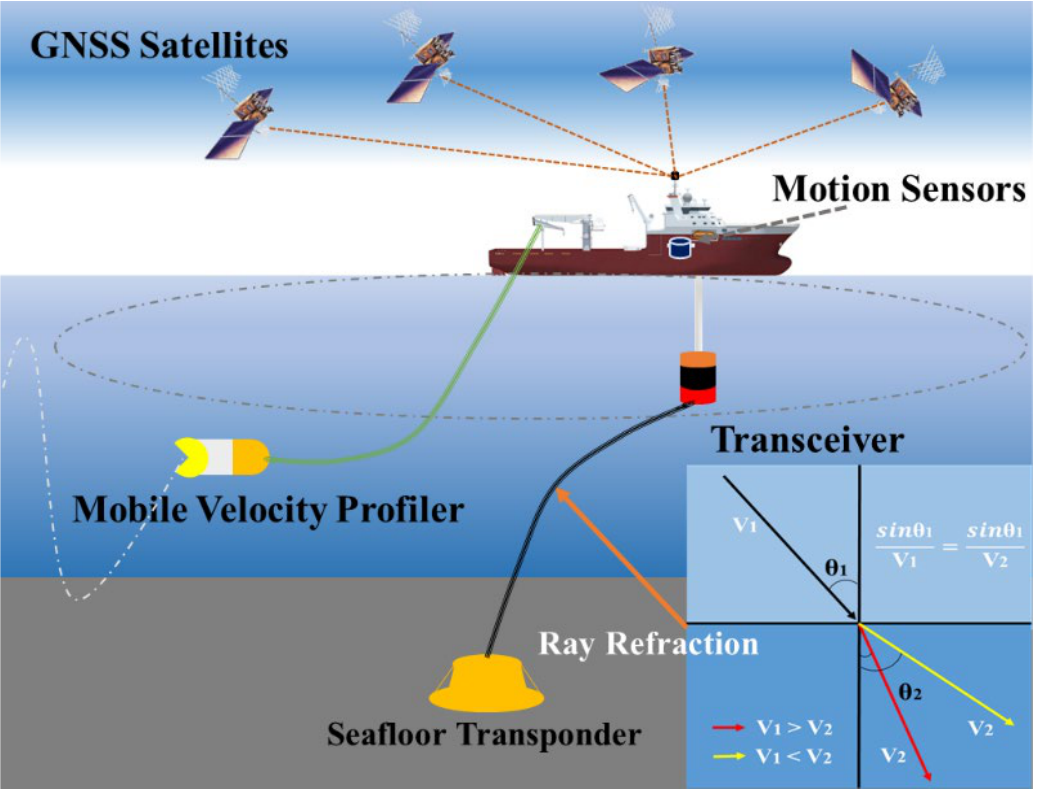
Figure 1. Schematic of the GNSS/Acoustic seafloor geodetic observation system.